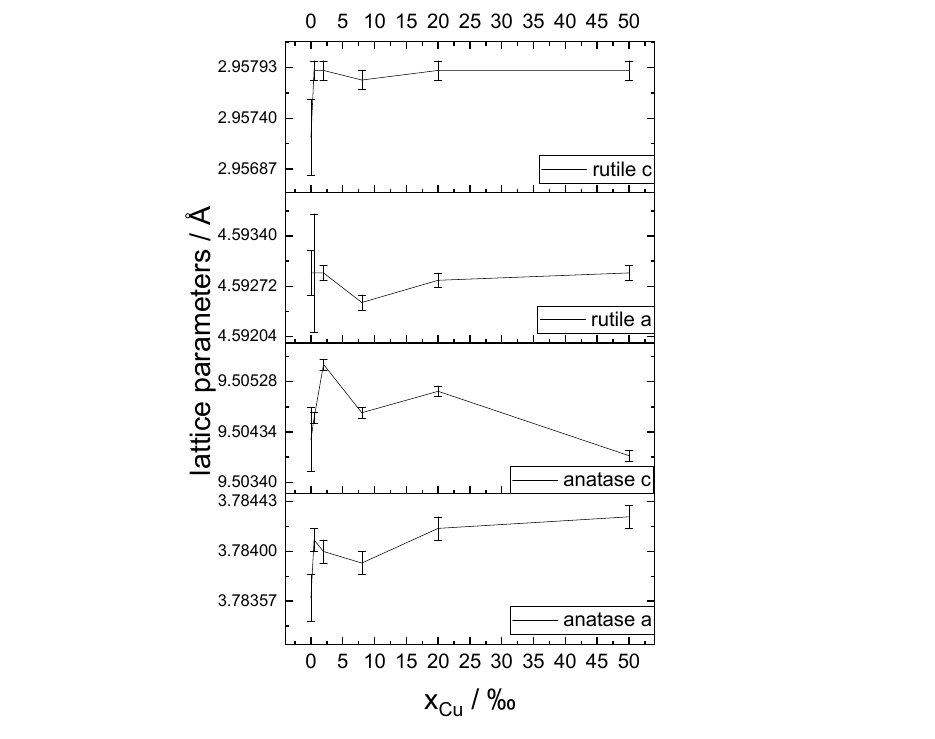
Figure 4. Lattice parameters of the crystalline anatase-type and rutile-type phase of different P25 samples doped with varying amounts of copper (P25 impregnated with copper acetate solution [x Cu = 0.5, 2, 8, 20, 50‰; x Cu = n Cu n Ti − 1 ] and calcined), according to the XRD measurements and Rietveld refinements of the diffraction data (see Figure 3, Table 2).